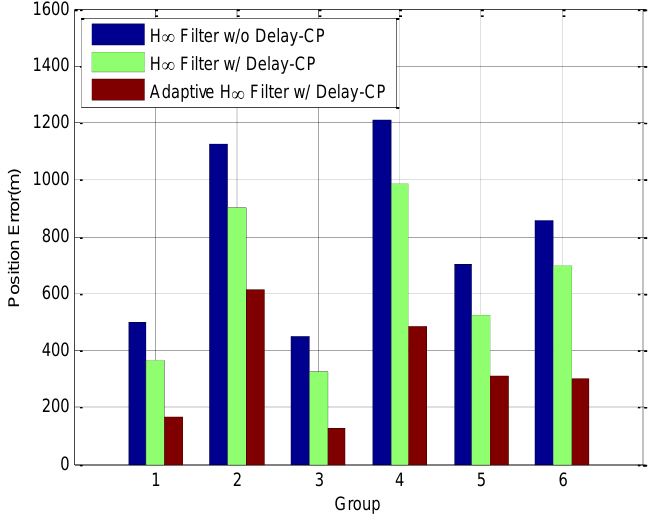
Figure 15. The histograms of position errors in 6 groups of vehicle experiment. Table 1. The position errors (m) in 6 groups of vehicle experiment.